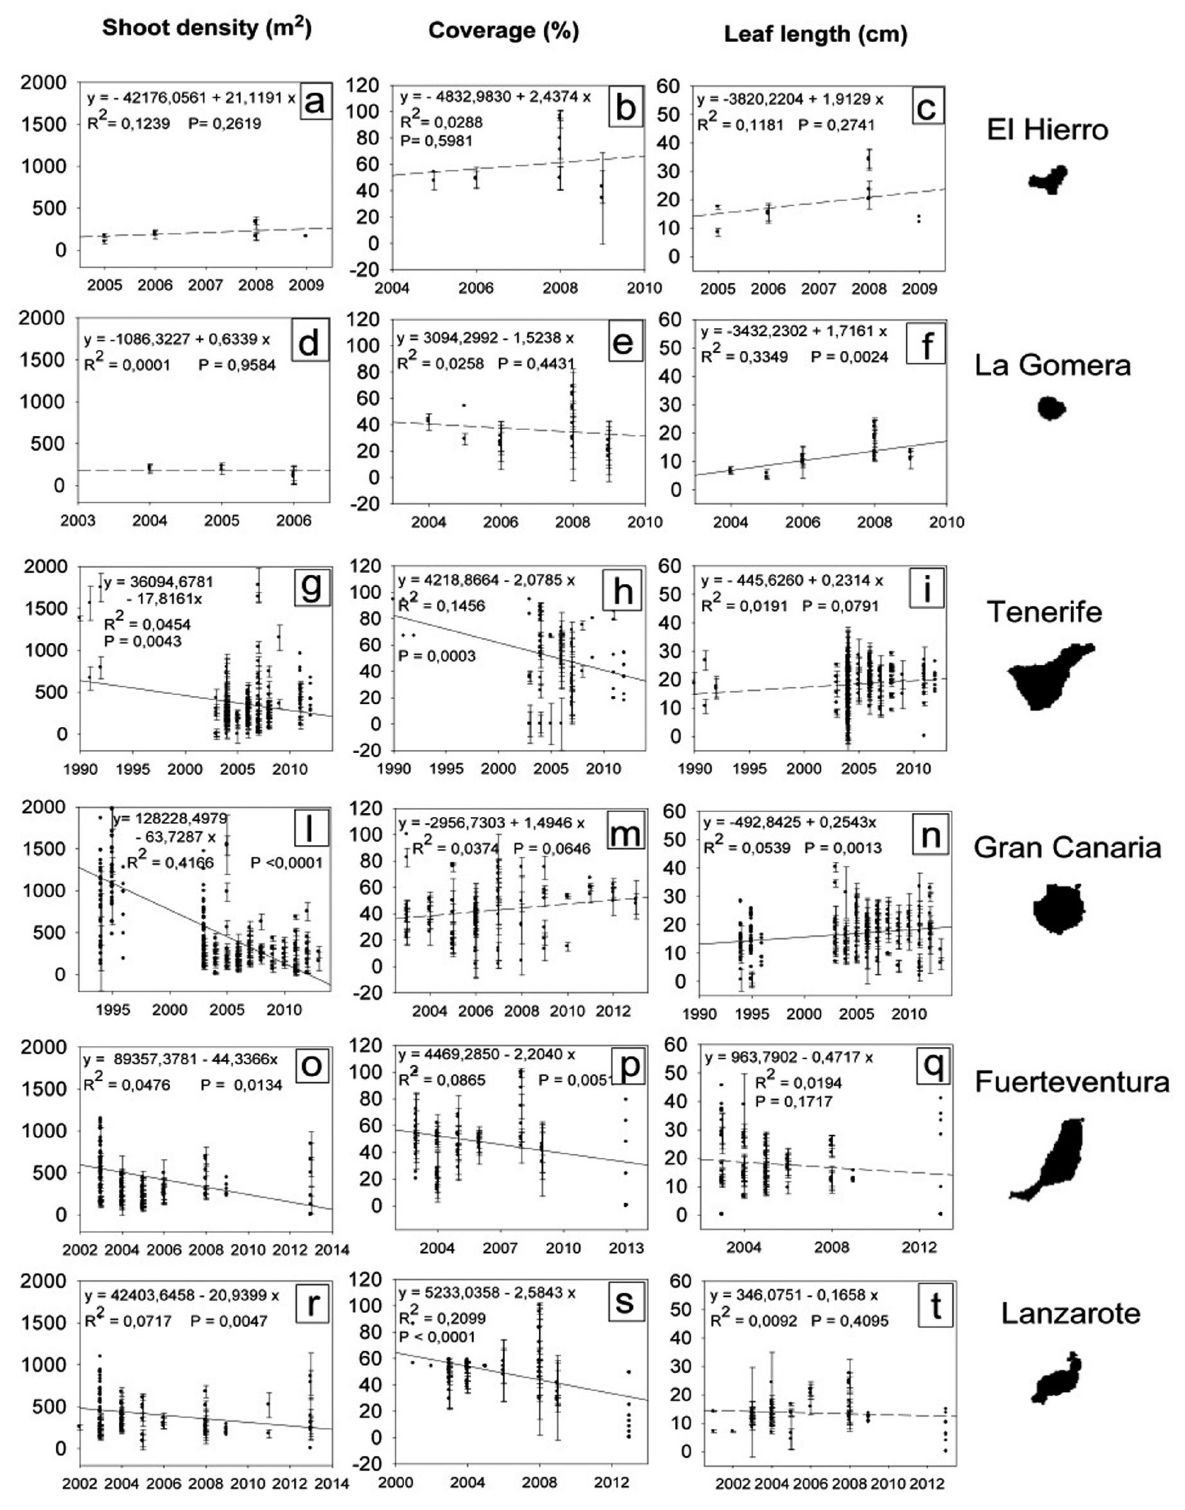
Fig. 2. – Changes over time of C. nodosa seagrass shoot density, coverage and leaf length in the Canary Islands. Linear regression equations are included (the R 2 coefficient was included to indicate the precision of the adjustment) for each structural descriptor and island. Solid lines denote statistically significant (P<0.05) adjustments, while dotted lines correspond to statistically non-significant adjustments